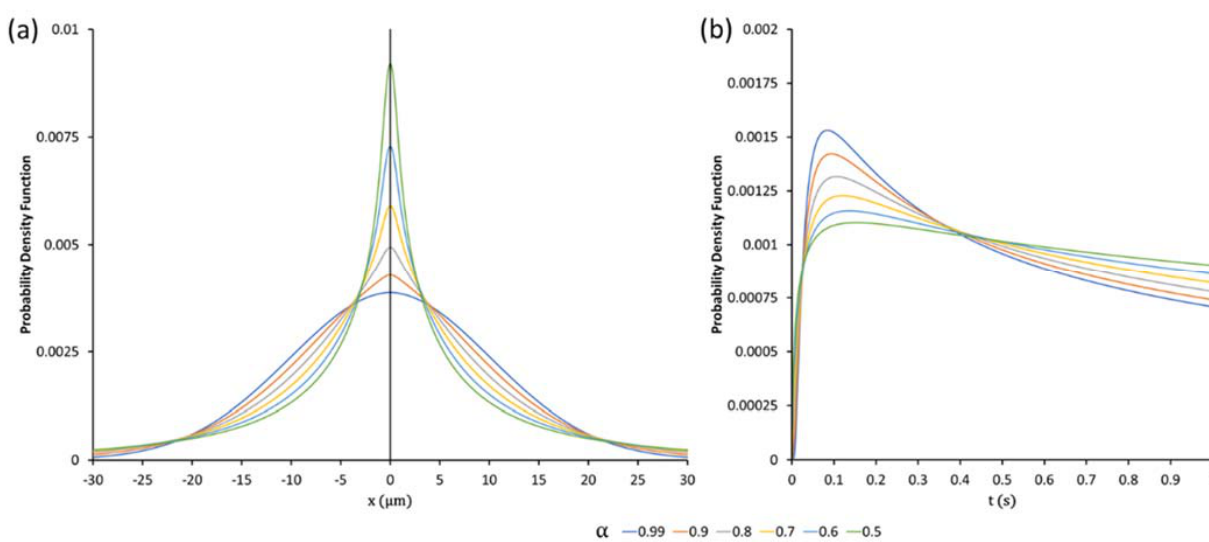
Figure 4. The one-dimensional quasi-diffusion propagator for an arbitrary diffusion coefficient, D 1,2 = 1.5 × 10 − 3 mm 2 s − 1 for 0.5 ≤ α ≤ 0.99. The one-dimensional probability density function is shown ( a ) in space at an effective diffusion time of Δ = 35.9 ms, and ( b ) in time at 𝑥 = 5 μ m.